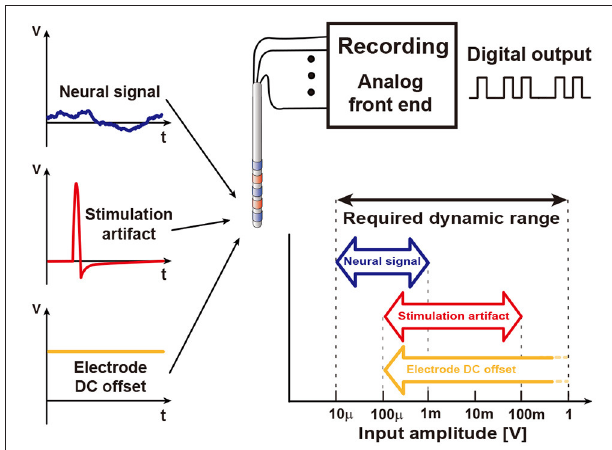
FIGURE 7 | Various inputs to a recording circuit. The amplitudes of these inputs are broad, forcing the recording circuit to have wide dynamic range.